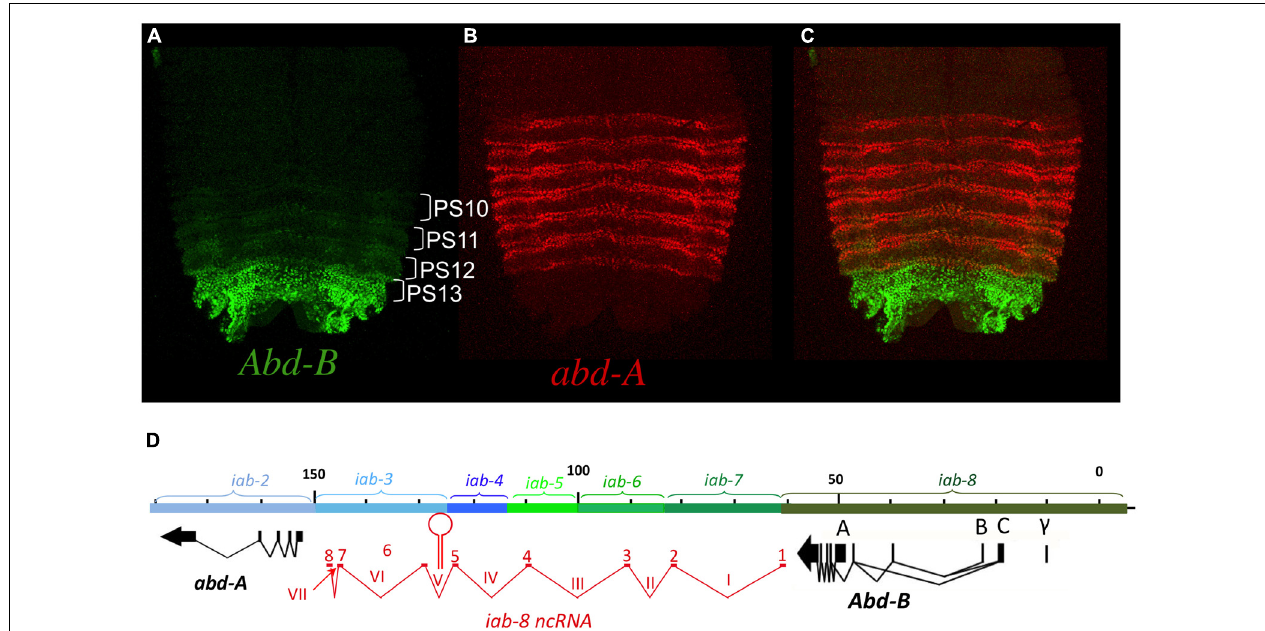
FIGURE 2 | abd-A and Abd-B are expressed in broad domains. Panels A , B , and C show pelts of stage 13 embryos. In these preparations, embryos were cut along the dorsal midline and flattened on a slide. Anterior is at the top. In stage 13 embryos, Hox gene expression is mostly visible in the epidermis with abd-A displayed in red and Abd-B in green. In panel A , Abd-B appears in a graded fashion from PS10 to PS13 (parasegments are marked by brackets). In these parasegments, Abd-B is produced from promoter A under the regulation of, respectively the iab-5, iab-6, iab-7, and iab-8 regulatory regions (see also text). In PS14 an alternative form of Abd-B is produced from promoters B, C, and γ .The abd-A expression pattern in PS7 to PS12 is shown in panel B . Both abd-A and Abd-B are displayed in panel C . Note that their